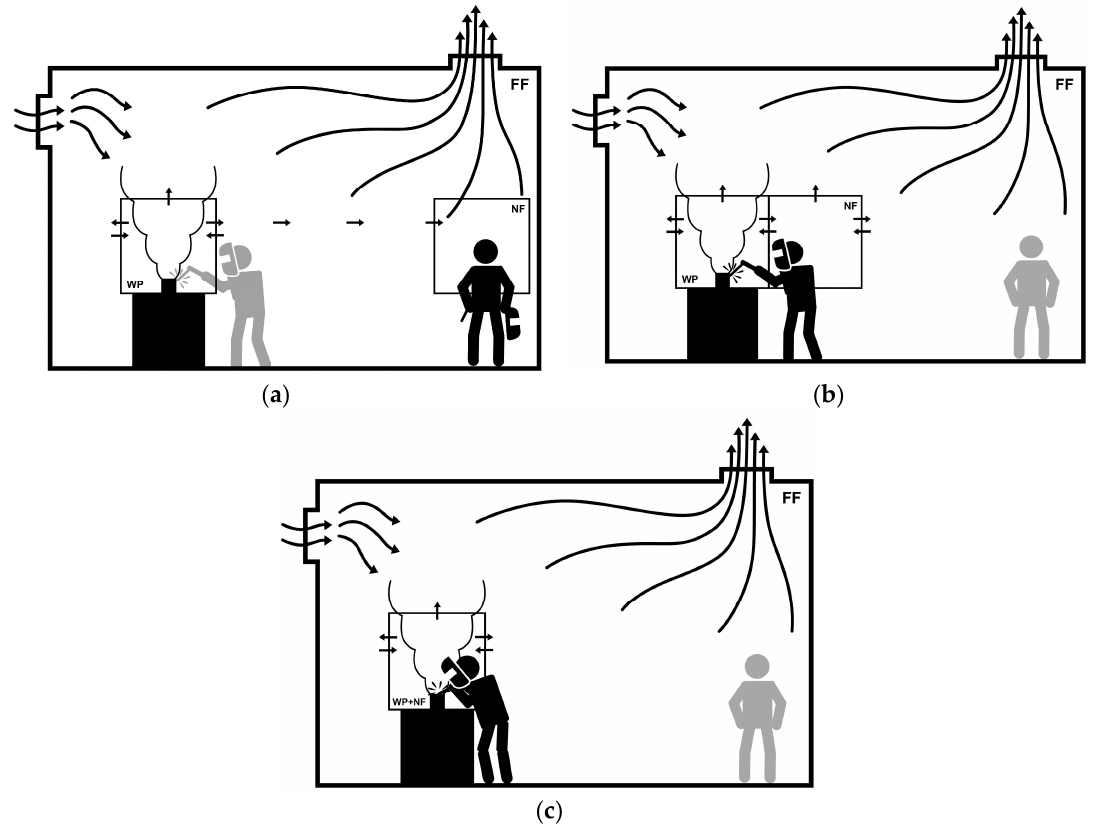
Figure 2. The ART model for welding fume should consider three scenarios, accounting for the interaction between the welder and the welding fume plume (WP): ( a ) Another welder colleague in a FF scheme; ( b ) A NF close to the WP scheme; ( c ) A NF and the WP are the same area scheme.